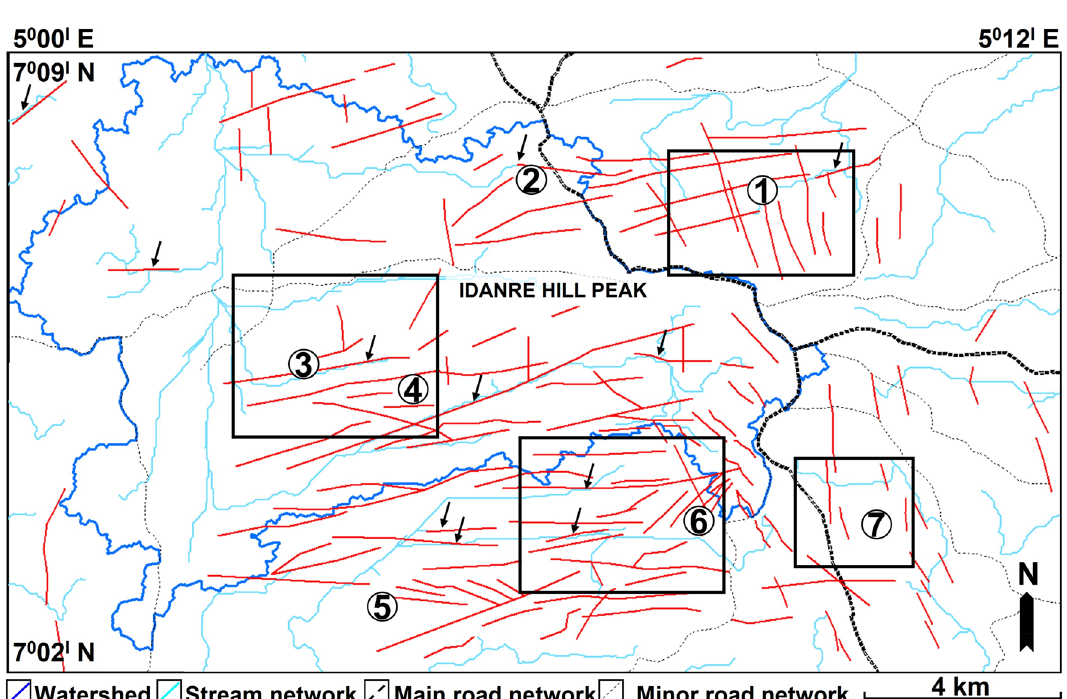
Figure 8. Stream network overlain on extracted lineaments within the study area. Black arrow shows areas where a stream segment overlaps with a